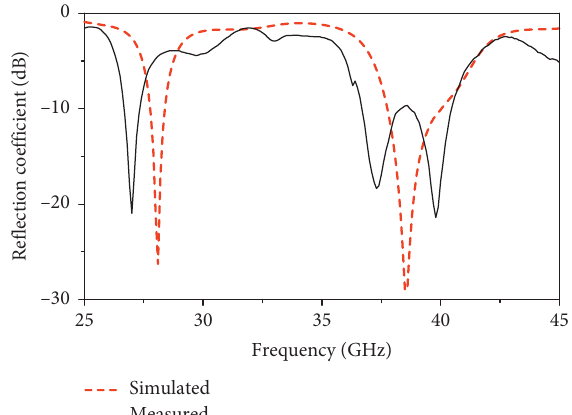
Figure 5: Simulated and measured refection coefcients of the proposed unit element.